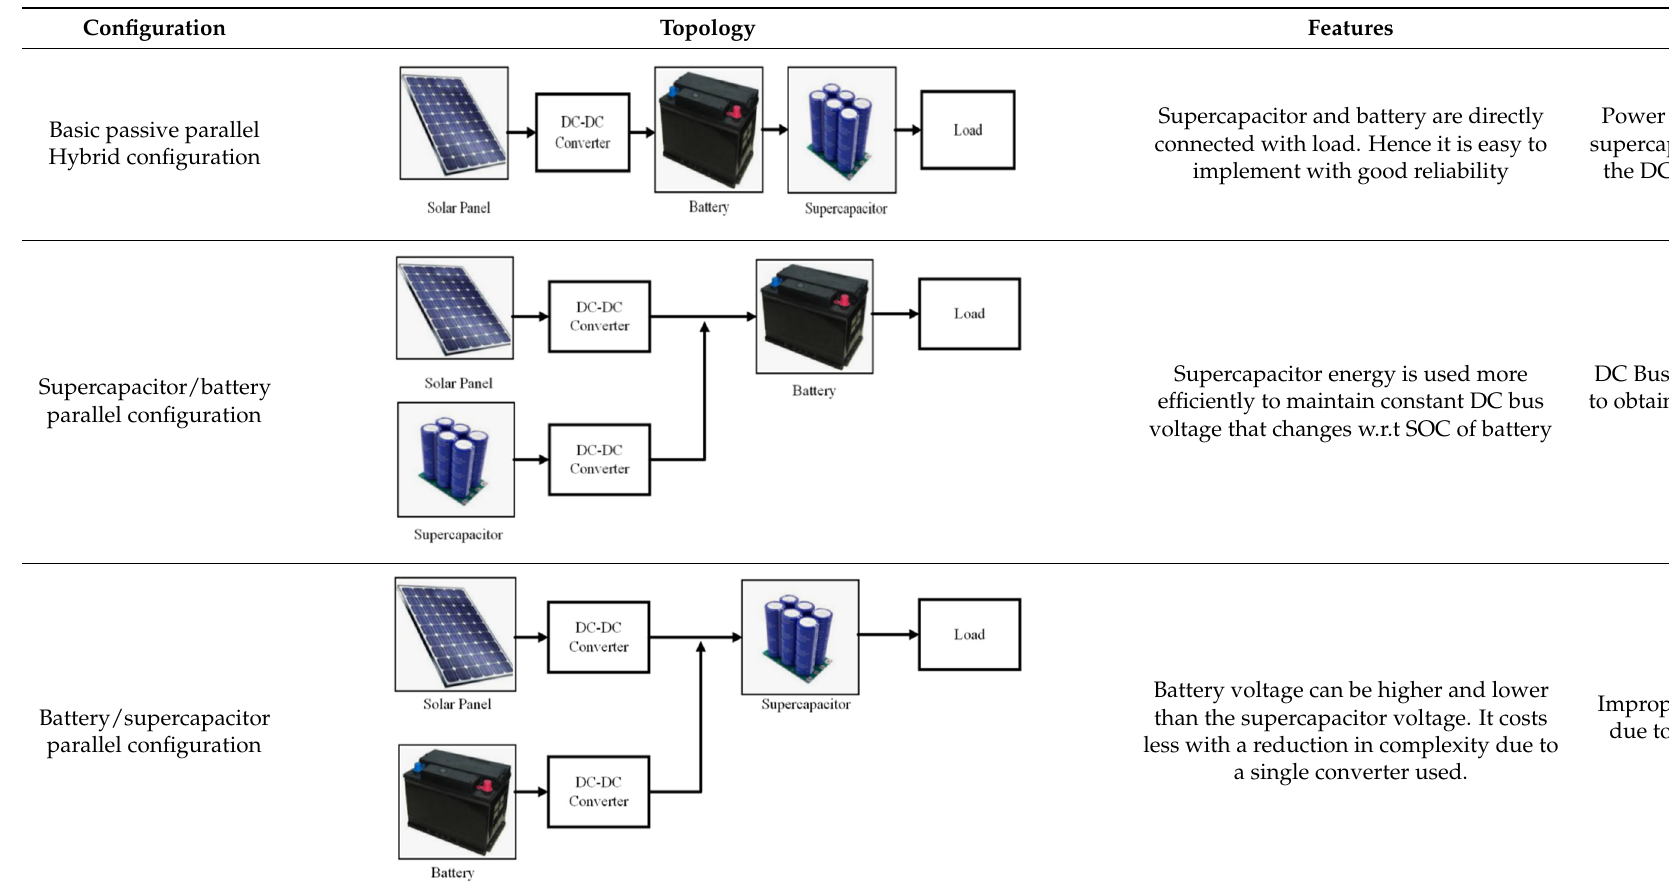
Table 1. Different system configurations.